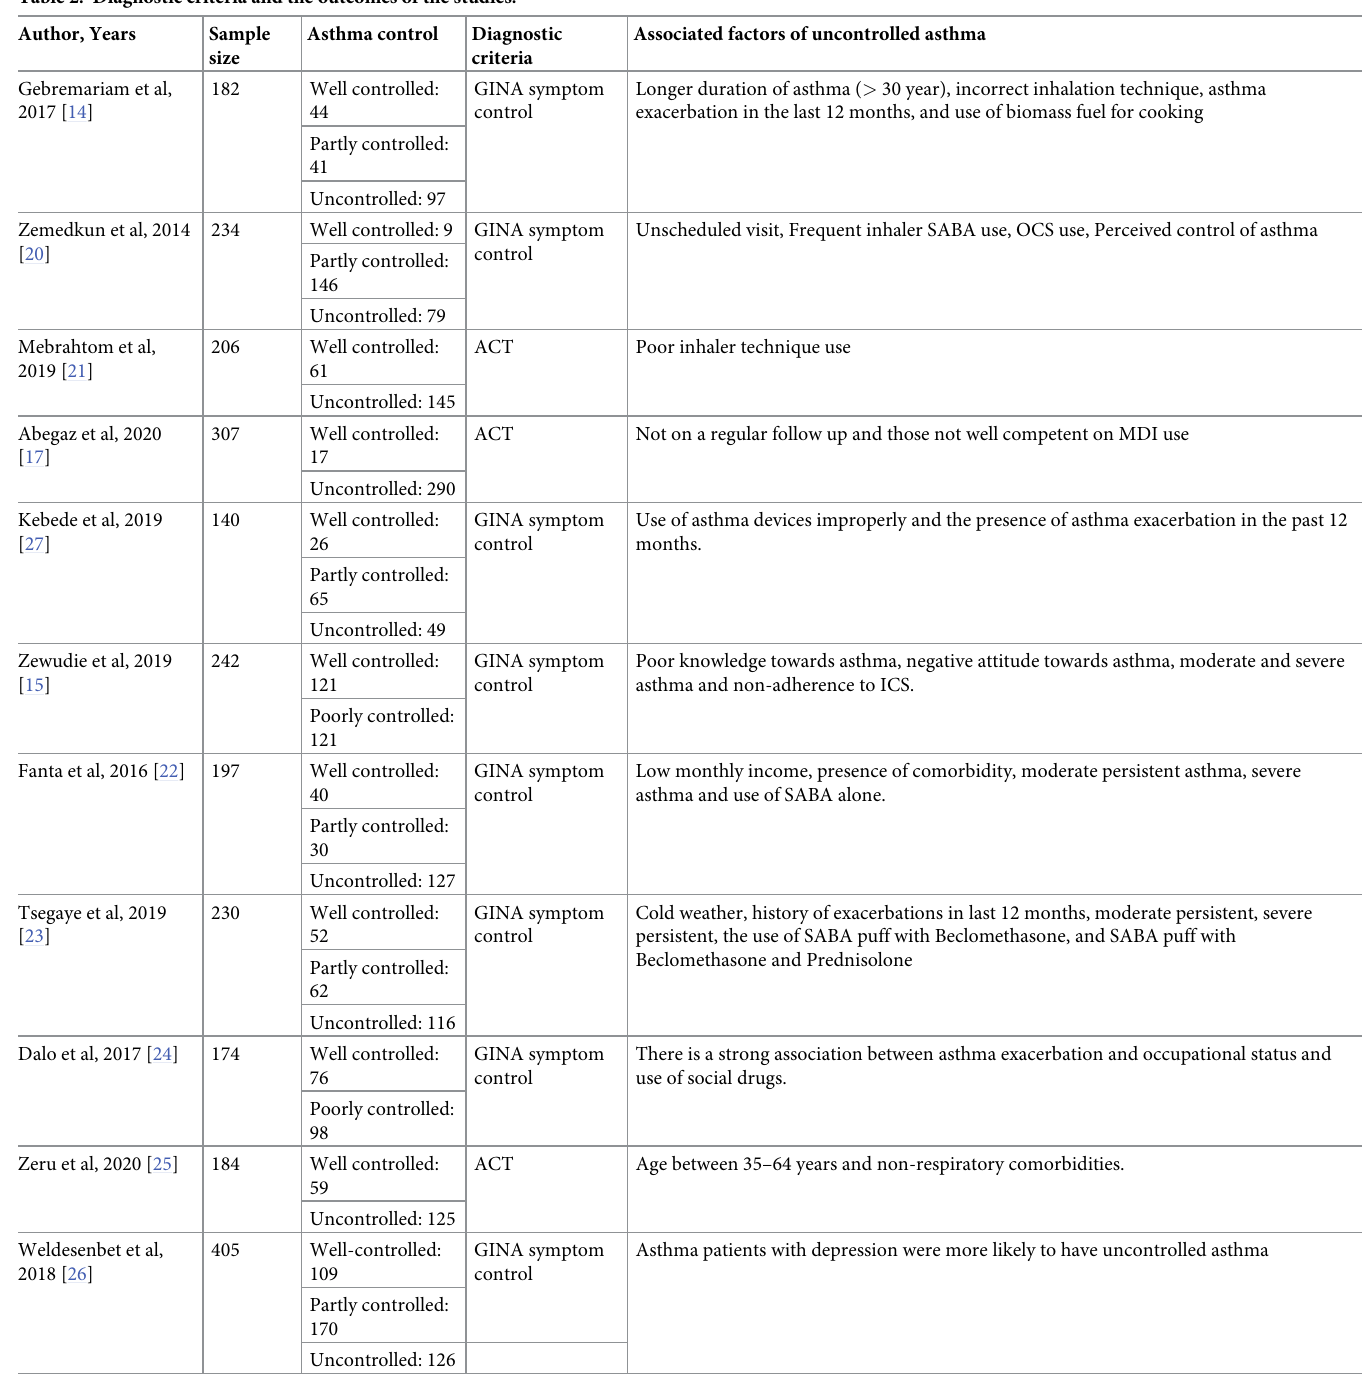
Table 2. Diagnostic criteria and the outcomes of the